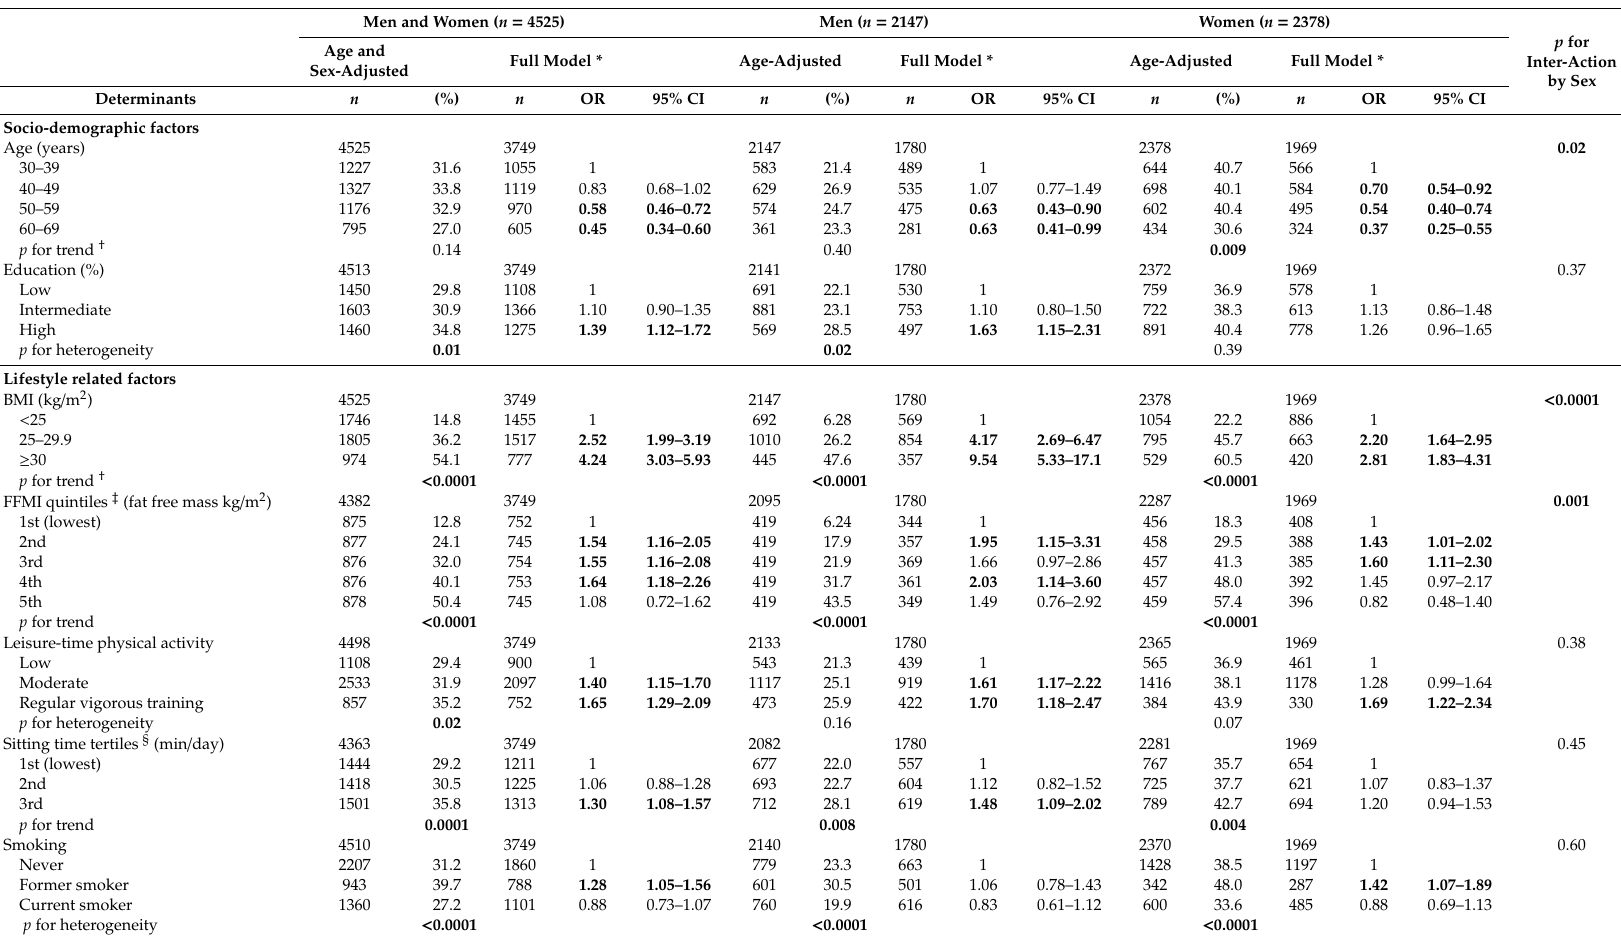
Table 2. Self-report dieting attempts during the previous year in men and women by potential determinants ( n =